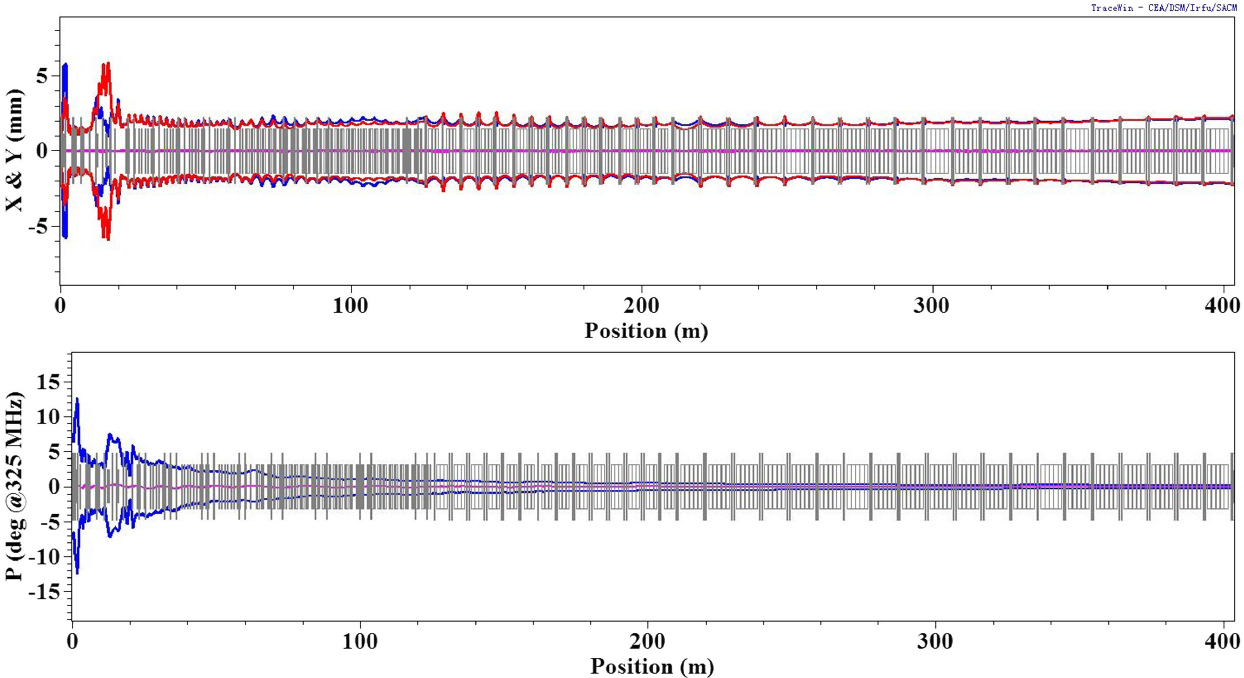
FIG. 27. Root-mean square envelope evolutions in the linac (upper: X in red, Y in blue; lower: phase